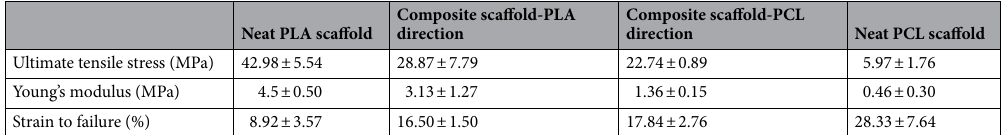
Table 2. Ultimate tensile stress, Young’s modulus, and strain to failure of neat PLA, neat PCL, and composite PLA/PCL scaffold (in PLA and PCL directions) (Results in this table are represented as mean ± standard deviation) (number of samples for each measurement = 3) (Statistical analysis with one-way ANOVA shows statistical significance with p-values less than 0.05).